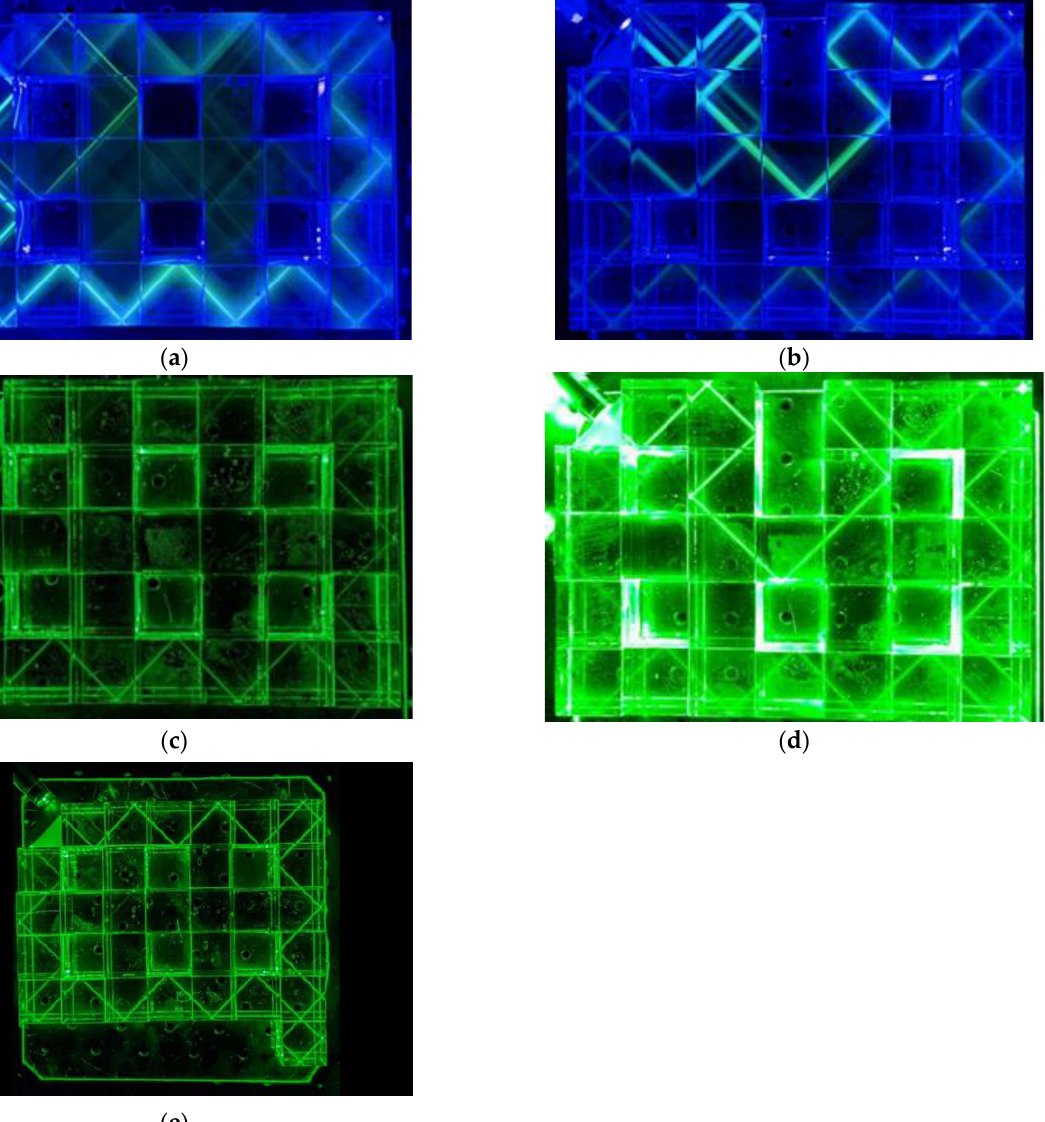
Figure 3. Beam trajectory photographs. The trajectory for smooth TPhTI ( a , c ) is robust against a defect obtained by removing prism resonator #3 ( b , d ) or attaching a new prism resonator below resonator #28 ( e ). Light beams for both a violet laser of 405 nm wavelength ( a , b ) and green laser of 532 nm ( c – e ) act in the same manner, proving the wavelength independence of the TPhTI principle.